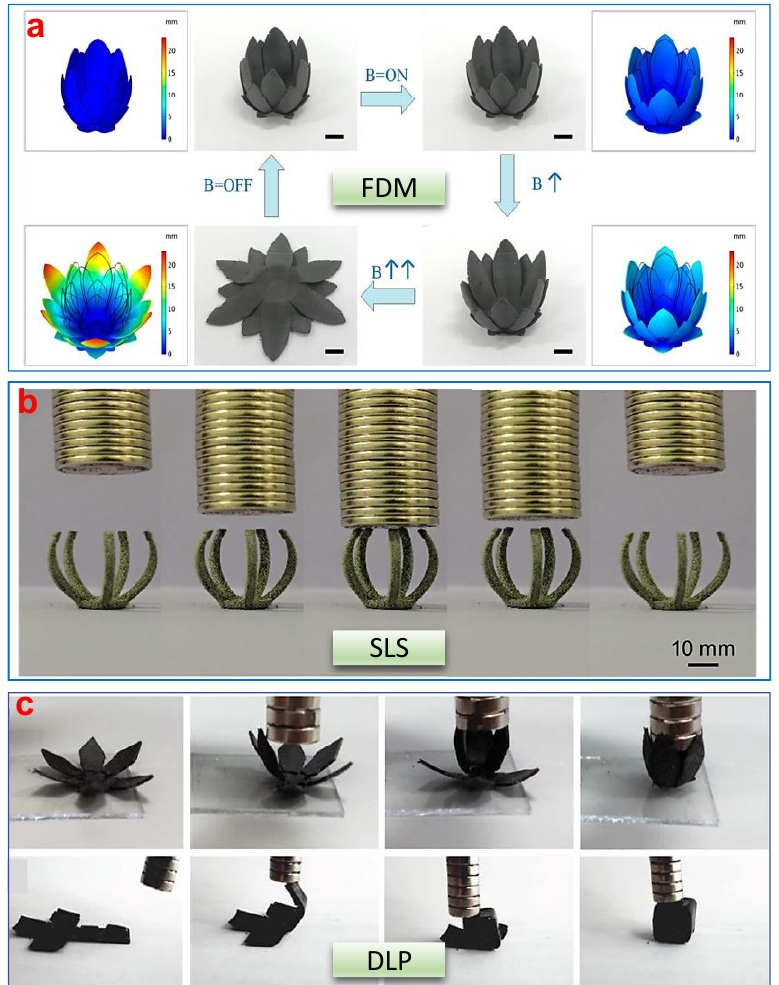
Figure 11. Examples of shape-morphing phenomenon demonstrated by 4D printed magnetic structures. ( a ) 4D effect of the flower-like biomimetic magnetic actuator under an external magnetic field, produced via FDM printing [253], ( b ) 4D effect of a gripper under an external magnetic field, produced via SLS printing [266], and ( c ) 4D effect of flower-like structure and folding of 2D to the 3D structure under an external magnetic field, produced via DLP printing [255].